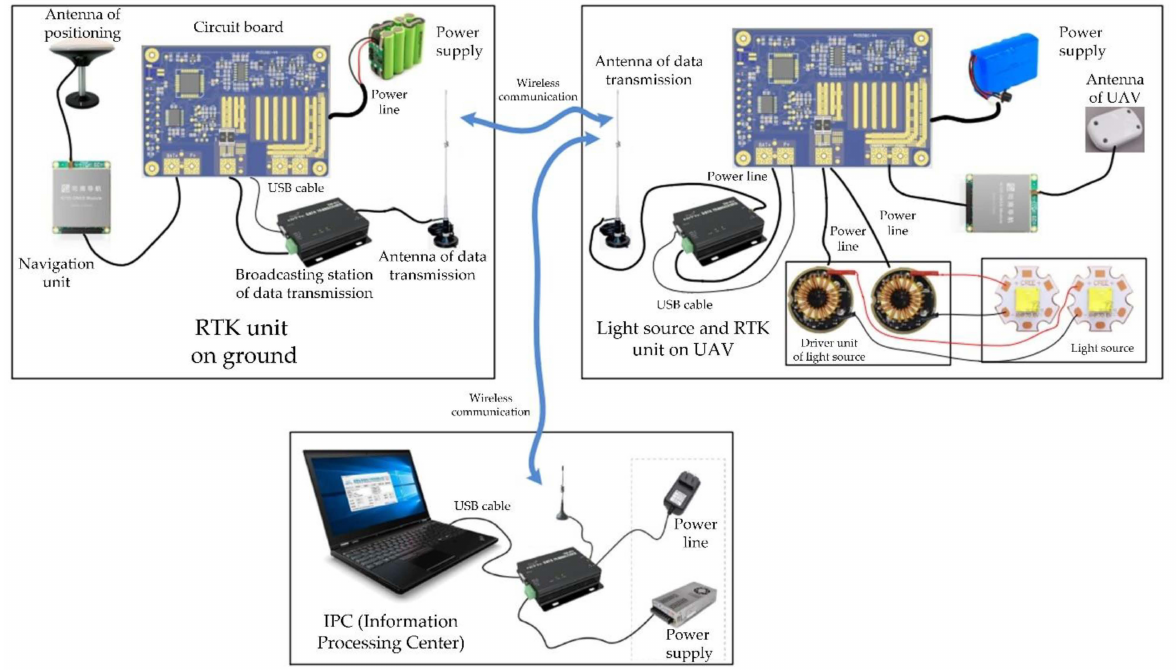
Figure 1. The design of the light source and RTK, exhibiting the RTK unit on the ground, the light source and RTK unit on the UAV, and the IPC (information processing